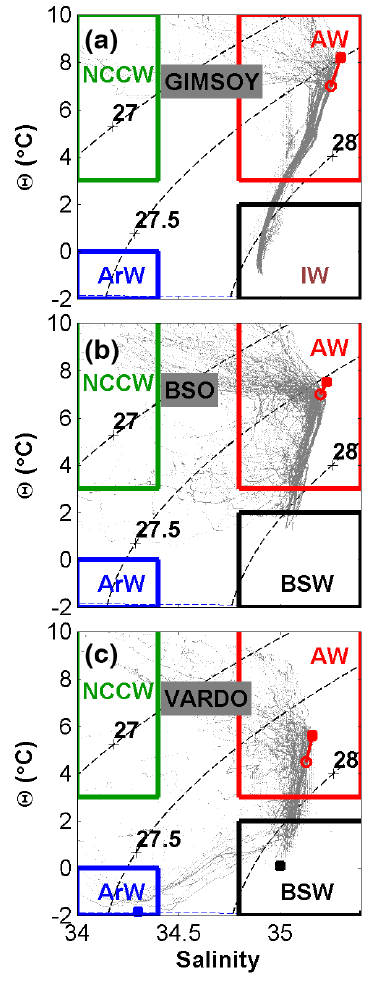
Figure 10. Potential temperature – salinity diagrams during the summer 2006–2011 period and shifts in the characteristics of the ideal Atlantic Water from the 1980–1985 period (empty circle) for (a) Gimsoy section, (b) BSO section and (c) Vardø section. Red dots: ideal Atlantic Water, black dot: ideal Barents Sea Water and blue dot: ideal Arctic Water. Intermediate Arctic Waters: